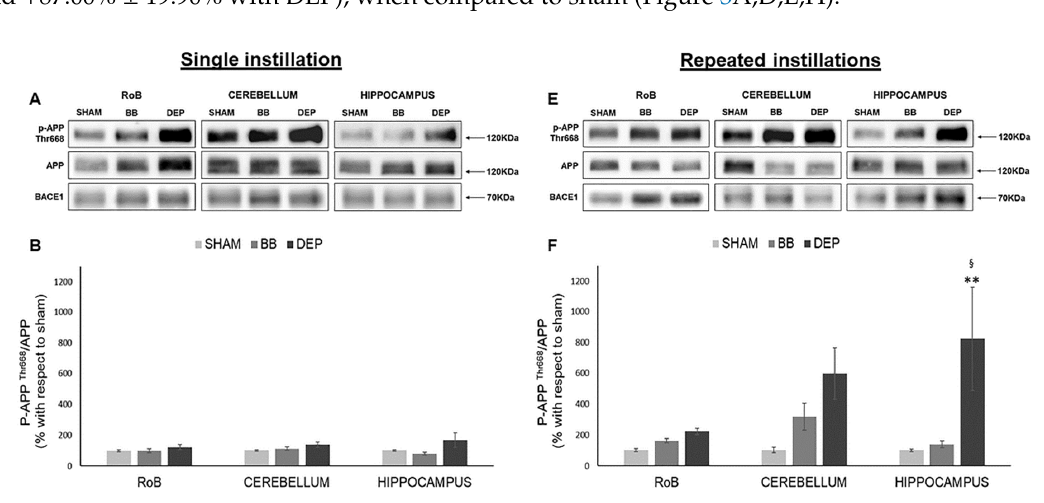
Figure 3. Amyloidogenic precursor protein (APP) processing analysis after single and repeated instillations of BB and DEP. Representative immunoblotting images of amyloid precursor protein (APP), phosphorylated APP on threonine 668 (p-APP Thr668 ), and beta-secretase 1 (BACE1) analysis in mice after single ( A ) and repeated ( E ) instillations with 50 μg of BB or DEP/100 μL 0.9% NaCl. Histograms display p-APP Thr668 /APP, APP, and BACE1 protein levels in mice after single ( B – D ) and repeated ( F – H ) instillations with BB and DEP, with respect to sham. Proteins are normalized to corresponding total proteins revealed by Ponceau in each lane (Figure S3, Supplementary Materials), and the data are expressed as means ± SEM ( n = 6). Statistical differences were tested accordingly by one-way ANOVA followed by Tukey post hoc comparison. ** p < 0.01 vs. sham mice; **** p < 0.0001 vs. sham mice; § p < 0.05 vs. BB-treated mice. 3. Discussion In this project, we analyzed and compared the effects of acute (single intratracheal instillation) and sub-acute (three intratracheal instillations in a week) BB and DEP peripheral administration on mouse brain regarding oxidative stress and inflammation induction, as well as their possible implications in brain pathologies. Alterations in some oxidative stress- and neuroinflammation-related markers were already found in rodents [38–40] and in vitro models [41–43] following diesel exhaust exposure. Moreover, most animal studies indicate that exposure to biomass particles can have a significant impact on the